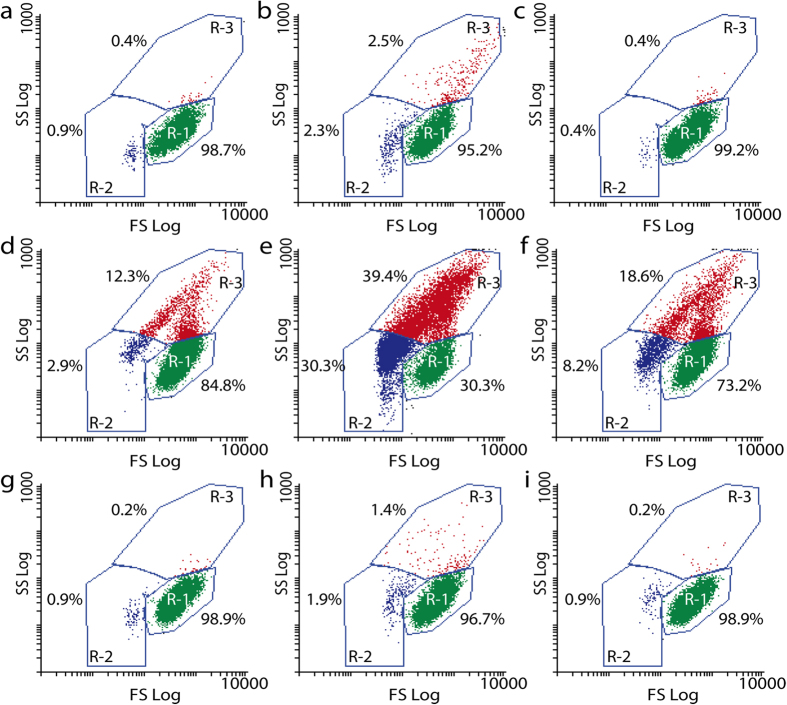
Flow Cytometry plots of cell complexity (SS) as function of cell size (FS) of P. subcapitata exposed during 48 h to CNP1 and CNP2 at 10 mgL−1.Control cells: (a) cells without treatment, (d) cells + Fe, (g), cells+PO43−, cells exposed to CNP1 (b), CNP2 (c), CNP1+Fe (e), CNP2+Fe (f), CNP1+PO43− (h) and CNP2+PO43− (i).